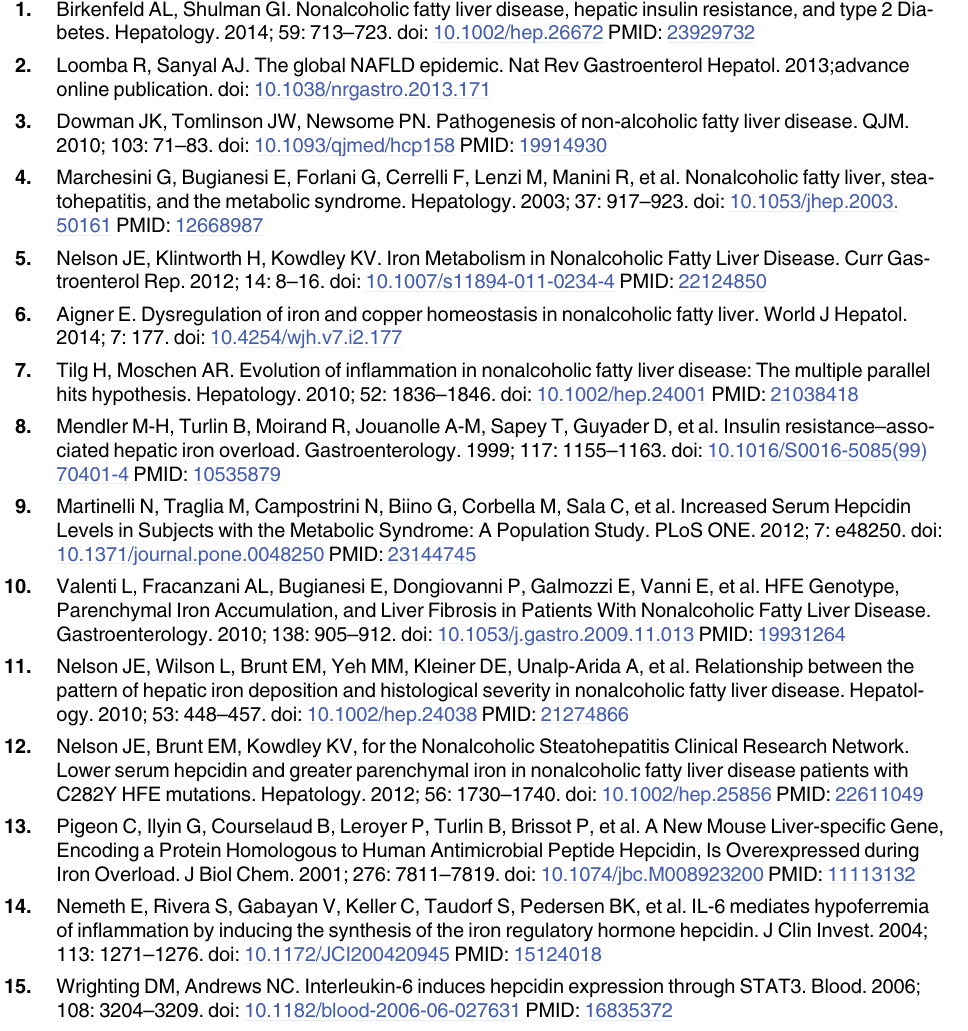
S1 Fig. STAT3 protein and mRNA expression, and ceramide-induced activation of STAT3 were inhibited by STAT3 siRNA and JAK inhibitor I,